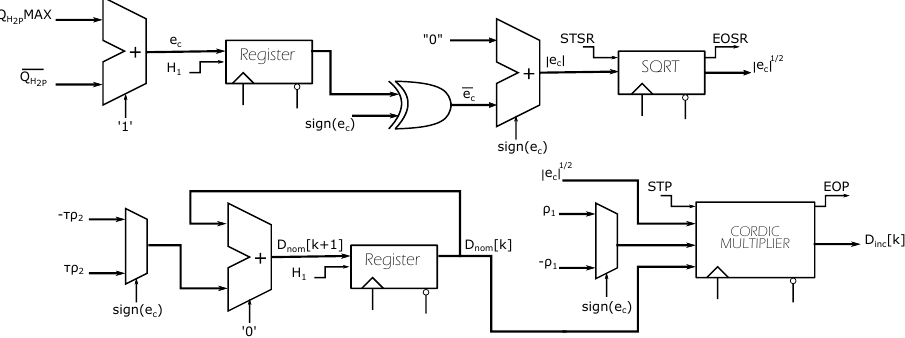
Figure 11. Digital architecture of the